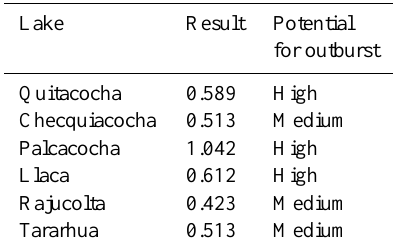
Table 10. The results of the semi-quantitative method defined by Bolch et al. (2011).